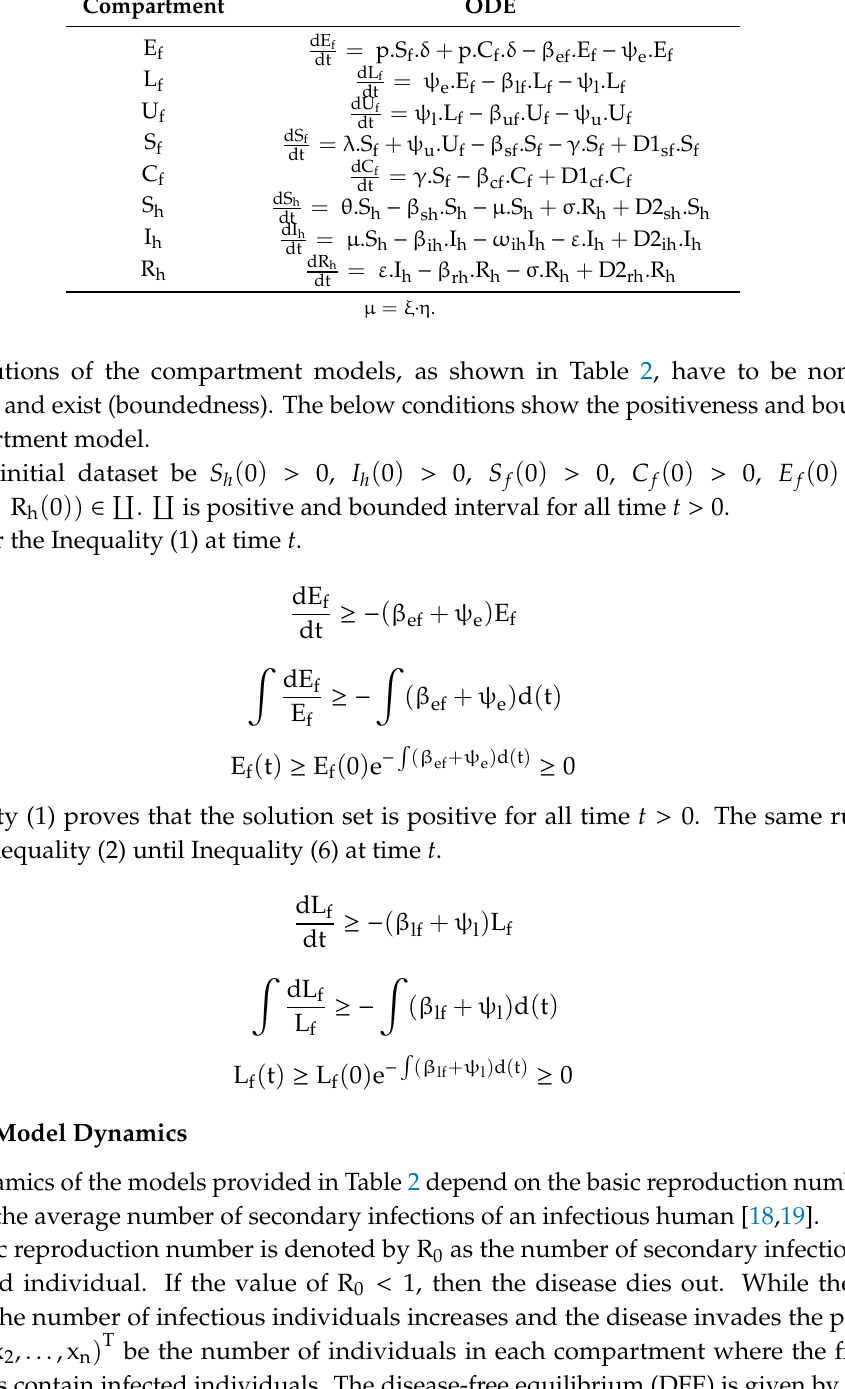
Table 2. Ordinary di ff erential equations (ODE) considering both the fly and the human system.